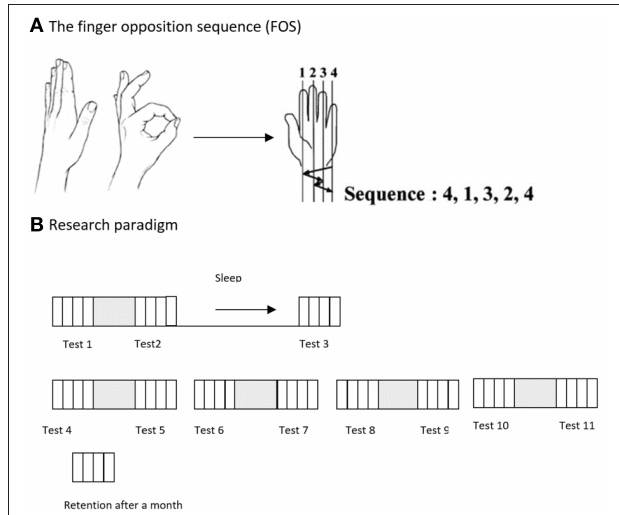
FIGURE 1 | (A) The Finger Opposition Paradigm: participants were asked to perform, repeatedly, a sequence of finger opposition movements as quickly and accurately as possible. (B) The time-line of the study: on the 1st week of the study the examinees were tested 3 times, before practicing the sequence, after the practice session, and at 24h post-training after a night’s sleep (Tests 1, 2, and 3). On the 2nd week participants were tested 8 times, before and after each of the 4 consecutive daily training sessions (Tests 4–11). An additional retention test was carried out 4 weeks after the final training session. Each performance test comprised four blocks of 30s continuous performance of the assigned